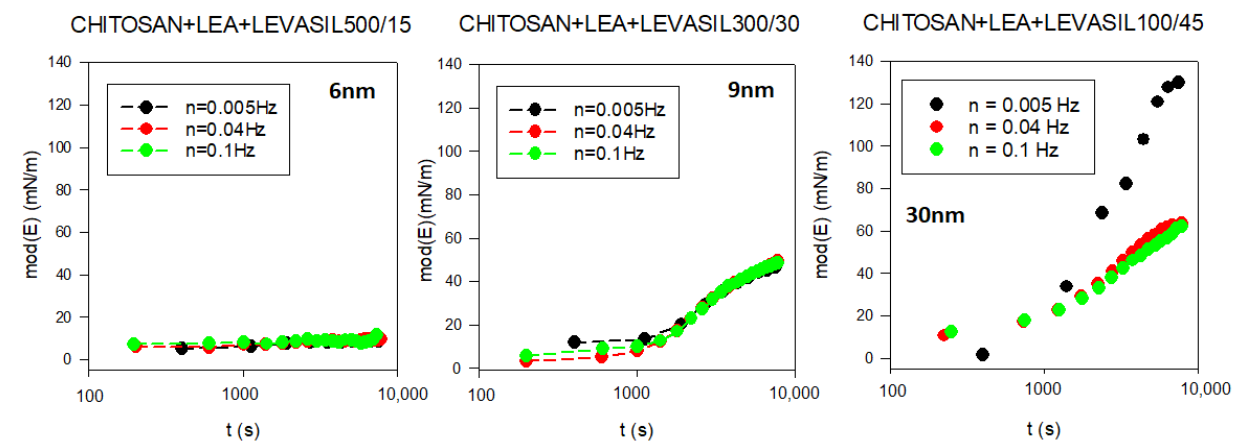
Figure 5. Evolution of the surface dilational elasticity module in chitosan—LAE—Levasil ® mixtures (depending on the type of Levasil ® used) .